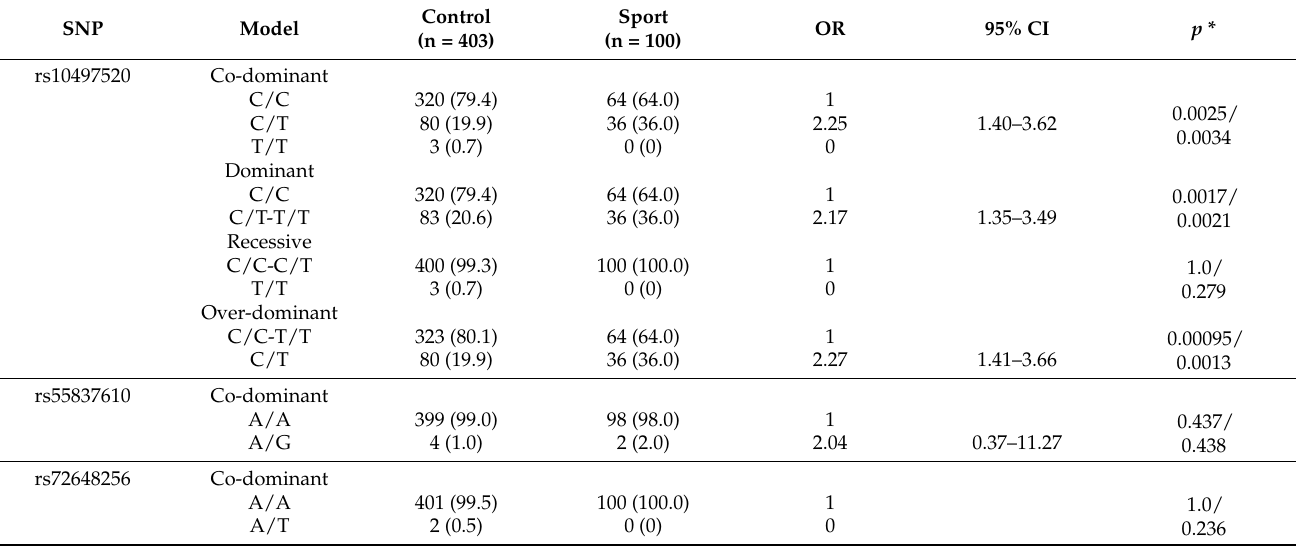
Table 2. Single SNP association analysis for cases (sprint/power sports) and